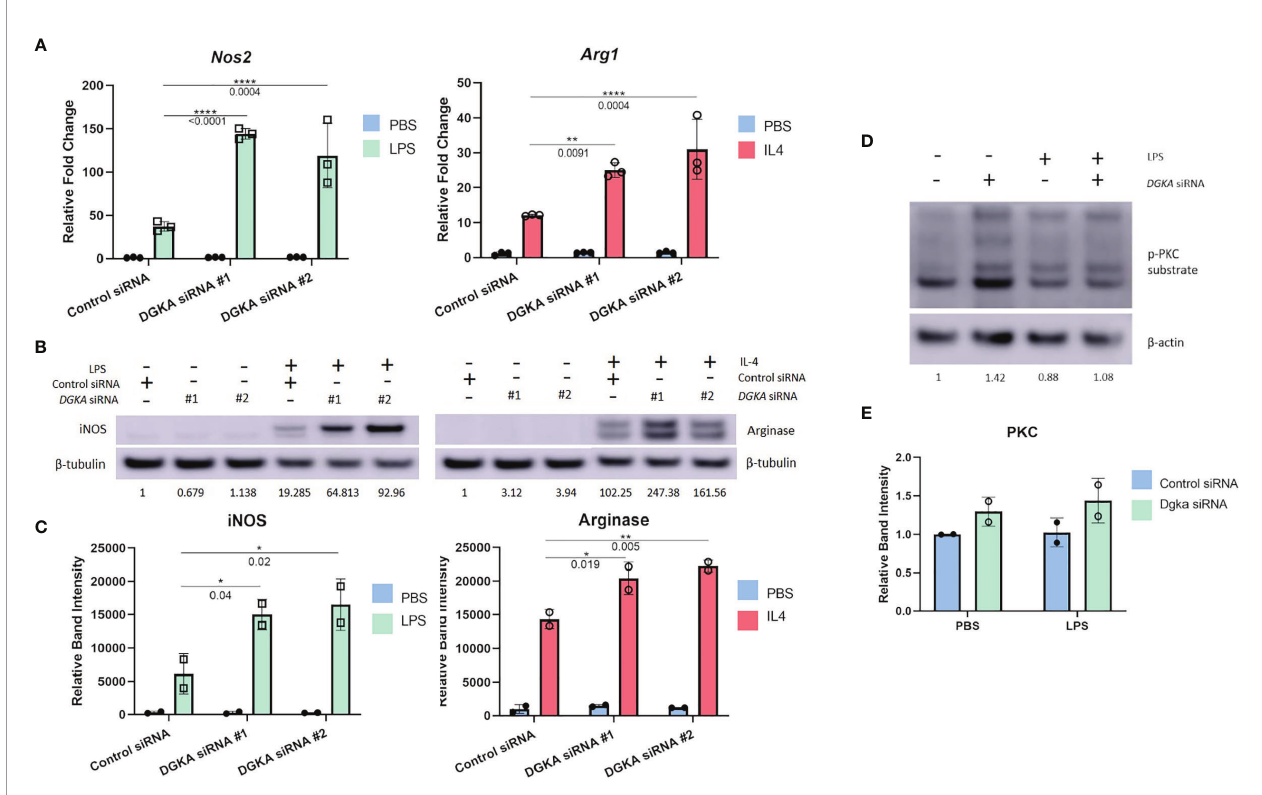
FIGURE 2 | Knockdown of Dgka from J774 murine macrophage cell line shows increased ampli fi cation of macrophage activation markers following LPS or IL4 stimulation. (A) J774 murine macrophages were stimulated with 500ng/mL LPS or 2ng/mL IL-4 following control or Dgka siRNA transfection and assessed by qPCR for Nos2 and Arg1 , respectively. Samples were normalized to the PBS treated control siRNA transfected cells. (B) Immunoblot analysis of whole cell J774 lysates probing for iNOS in LPS-treated cells and Arginase in IL4-treated cells. Relative band intensities normalized to PBS-treated control are indicated as text below the immunoblots. Representative data shown. (C) Summary plot depicting quanti fi cation of immunoblot band intensity from two independent experiments as in (B) . (D) J774 macrophages transfected with either control siRNA or Dgka siRNA were treated with LPS for 24h, and the protein expression of phospho-PKC substrates is shown by immunoblot. Relative band intensities normalized to PBS treated control are indicated below the immunoblots. (E) Summary plot depicting quanti fi cation of immunoblot band intensity of two independent experiments as in (D) . Error bars: SD. *p < 0.05, **p < 0.01, ****p < 0.0001; Two-way ANOVA with Tukey post-hoc